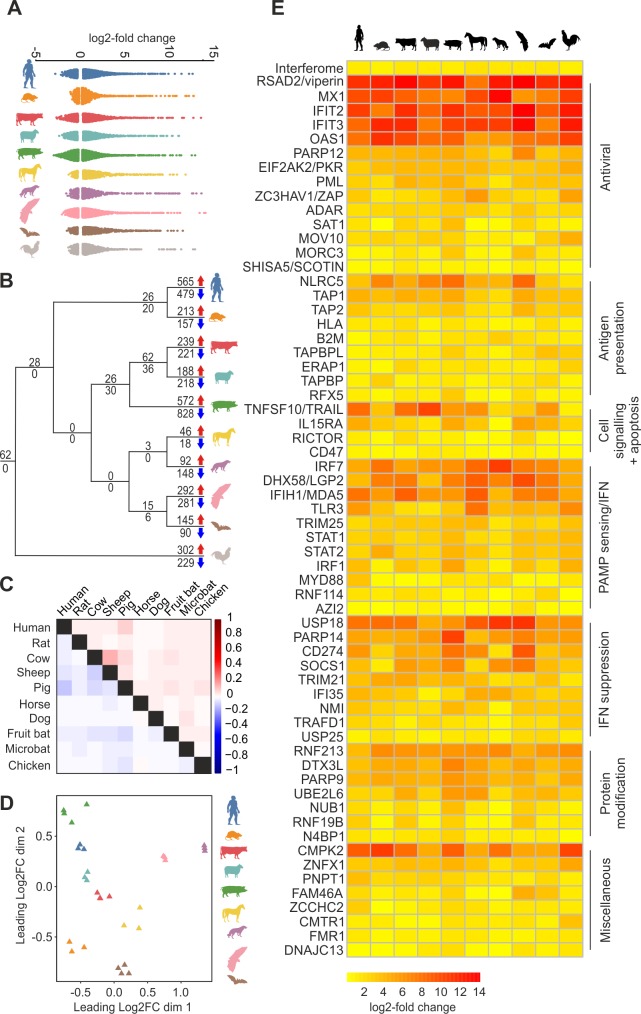
Patterns of differential gene expression in response to type I IFN among cells from the 10 vertebrate species used in this study.(A) The patterns of differential expression of ISGs and IRGs are broadly similar in cells derived from 10 different animal species. Each dot in the panel represents a gene that is differentially expressed in response to type I IFN treatment (S1 Data). (B) Number of ISGs (above line, red arrow) and IRGs (below line, blue arrow) are plotted on the branches of a simplified phylogenetic tree (branch lengths are not shown to scale). ISGs common to every species (n = 62) are located at the root of the tree with an additional 28 ISGs up-regulated by all mammalian species used in this study. At the tips of the tree lie genes that are only up- or down-regulated in an individual species in our study. (C) Normalised correlation matrix showing pairwise comparisons between ISGs (red) and IRGs (blue) of the indicated animal species (S1 Data). (D) A PCA of the log2FC data of the one-to-one orthologs up-regulated by all nine mammalian species used in this study (S1 Data). Each point represents an animal or experiment, coloured according to species. The distribution of the samples reflects expression patterns. Separate animals/experiments cluster according to species, with the pig and human showing similar patterns. (E) A heatmap of the relative expression of the 62 vertebrate core ISGs. The first row (labelled as ‘Interferome’) represents the average log2FC of all up-regulated ISGs for each animal species. Up-regulated paralogs have been averaged in the case of genes for which there are expansions; for example, the rat has two copies of MX1 compared to the single copy in the remaining species (S1 Data). IFN, interferon; IRGs, interferon-repressed genes; ISGs, interferon-stimulated genes; log2FC, log2 fold change; PCA, principal component analysis.